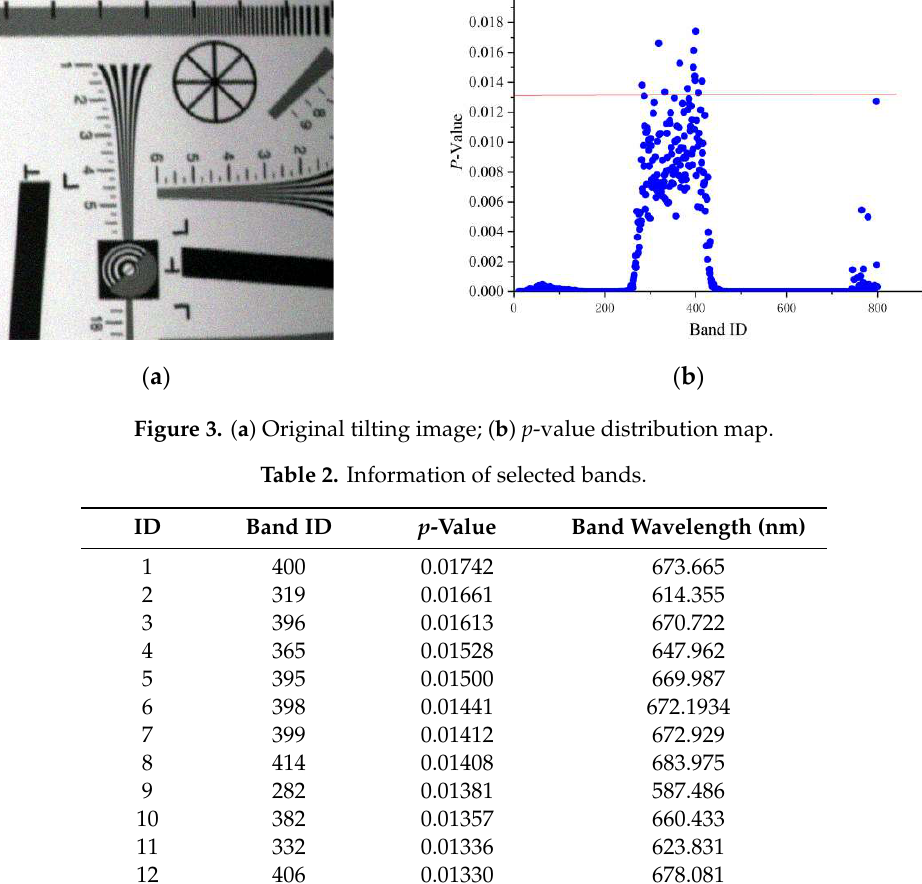
Table 2. Information of selected bands.